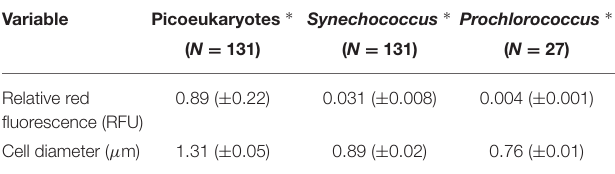
TABLE 6 | Average relative red fluorescence and cell size for each community of picophytoplankton derived from the flow cytometry data.